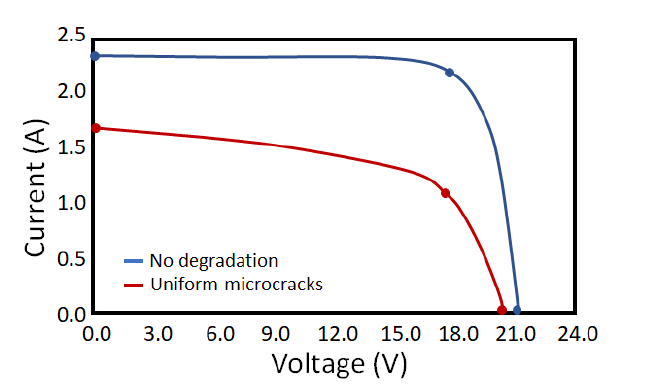
Figure 15. Microcracks degradation effect on I-V curve